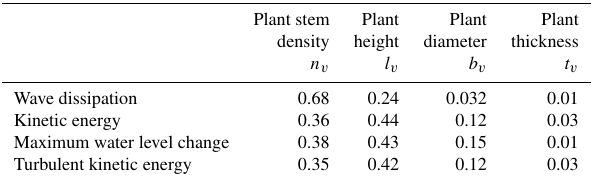
Figure 7. Standard deviation in TKE (cm 2 s − 1 ) in the presence of vegetation (plan view). The area of the vegetation patch is high- lighted in the middle of the domain. Table 3. Sobol’ indices for all the